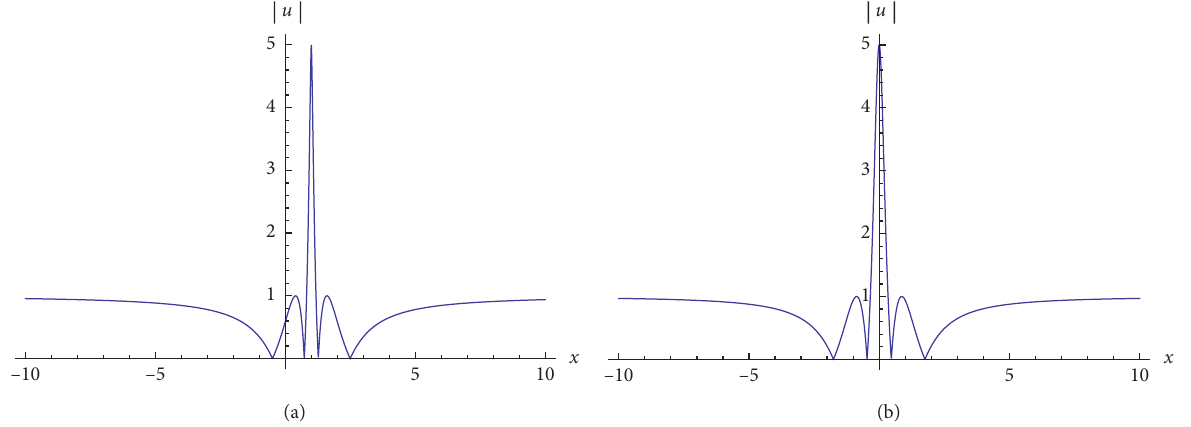
Figure 8: Amplitudes of first-order fractional rogue wave solution (39) and its comparison with the integer order. (a) α � 9/7, a � 1, and t � 1; (b) α � 1, a � 0, and t � 0.